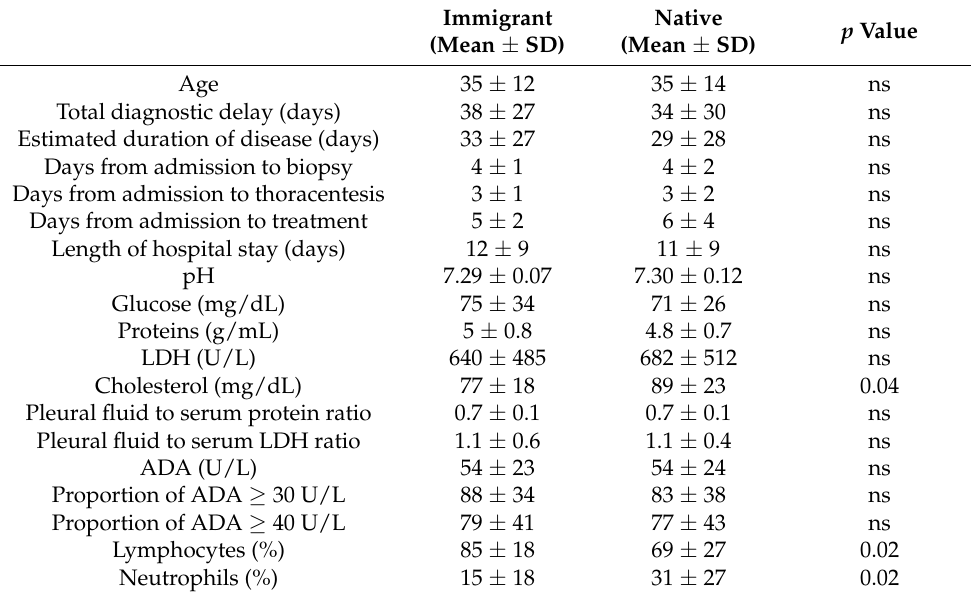
Table 5. Comparison of diagnostic delay times and biochemical characteristics of tuberculous pleural effusion in the immigrant and native